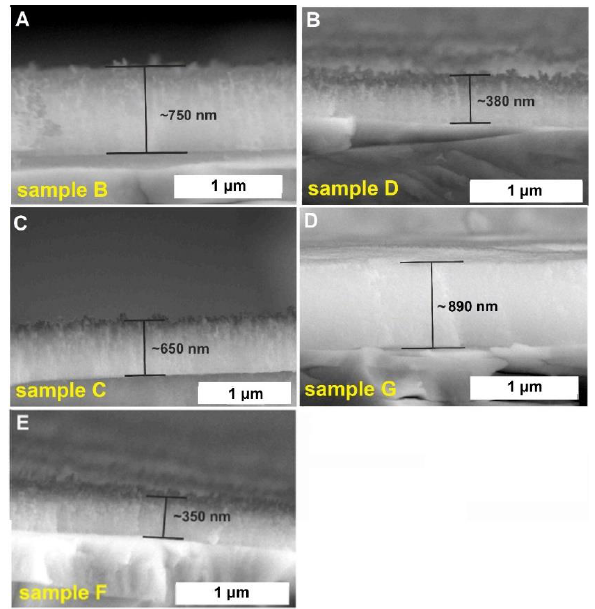
Figure 2. Cross-sectional SEM images of anodic WO 3 layers obtained in different anodizing conditions: 1 M(NH 4 ) 2 SO 4 + 0.075 M NH 4 F at 50 V for 4 h - sample B ( A ), 1 M Na 2 SO 4 + 0.19 M NH 4 F at 40 V for 15 min – sample D ( B ), 1 M Na 2 SO 4 + 0.12 M NaF at 40 V for 2 h – sample C ( C ), 0.27 M NH 4 F (in 2.2 wt.% H 2 O in ethylene glycol) at 10 V for 1 h – sample G ( D ), 0.15 M NH 4 F at 30 V for 30 min ( E